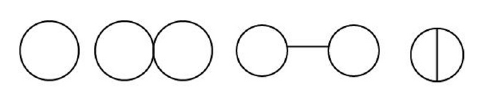
Figure 9 . Diagrams contributing to the statistical